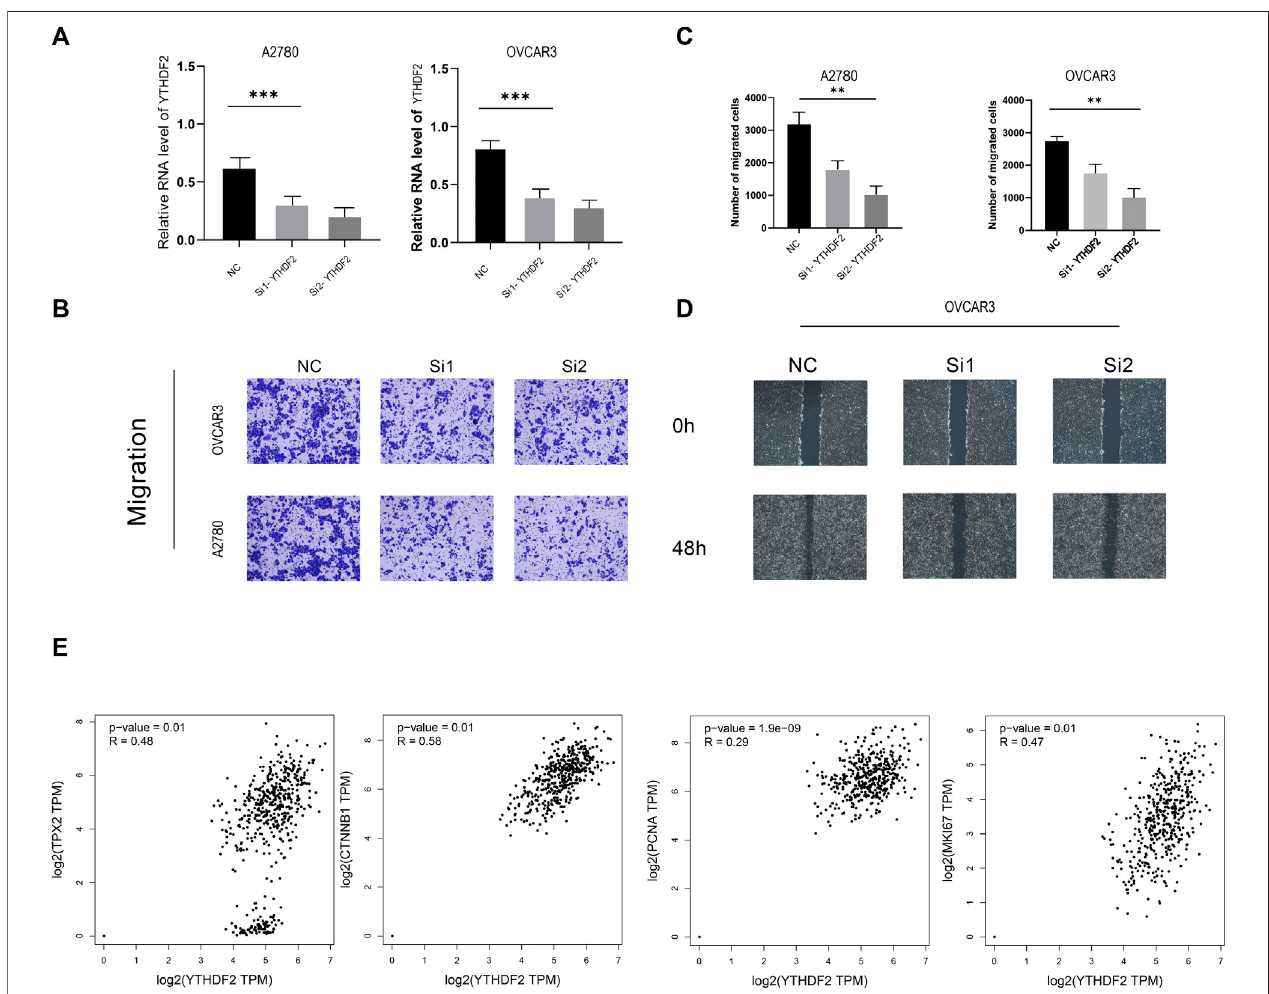
FIGURE 8 | A2780 and OVCAR3 Cell experiments. (A) RNA level of YTHDF2 in A2780 and OVCAR3 Cell experiments following YTHDF2 knockdown. (B,C) Knockdown ofYTHDF2 decreased cellmigrationasdetectedbyTranswellassays. (D) Knockdown ofYTHDF2 decreasedcell migration asdetected byWound-healing migration assays. (E) . YTHDF2 shows positive correlation with TPX2, MKI67, PCNA and CTNNB1.